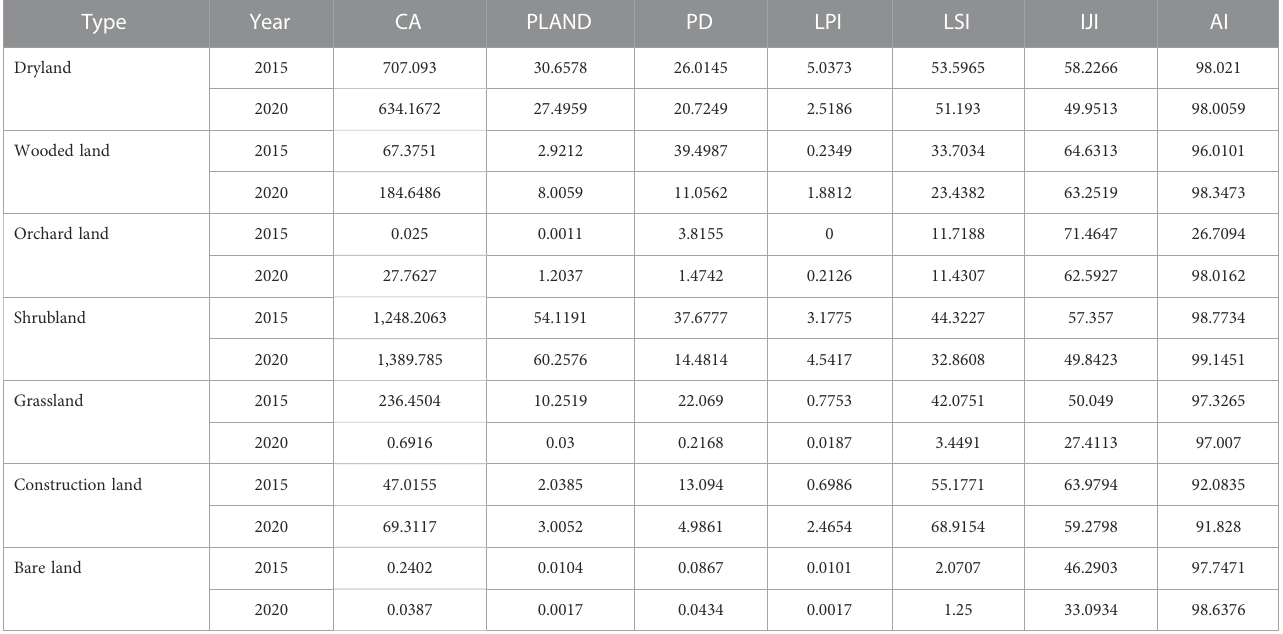
TABLE 5 Landscape pattern indices at the patch level in the study area for 2015 – 2020.